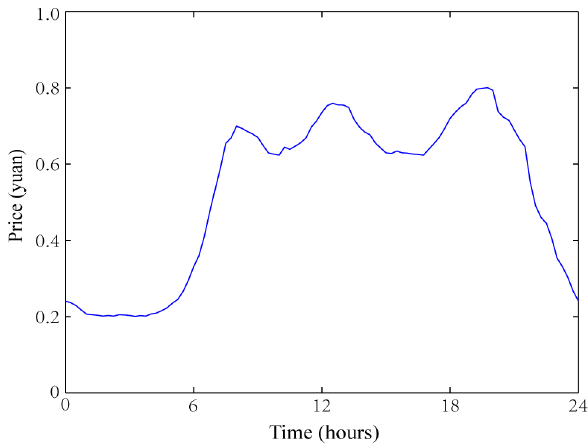
Figure 1. Day-ahead real-time pricing.